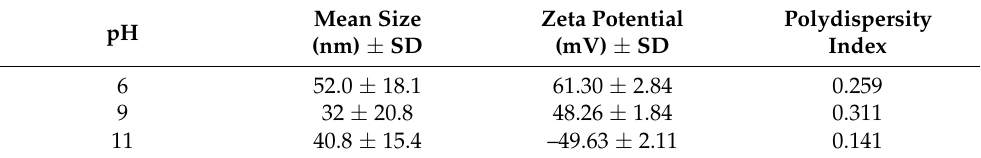
Table 2. Mean size (by DLS measurement) and zeta potential of gallic acid-coated gold nanoparticles with various levels of pH